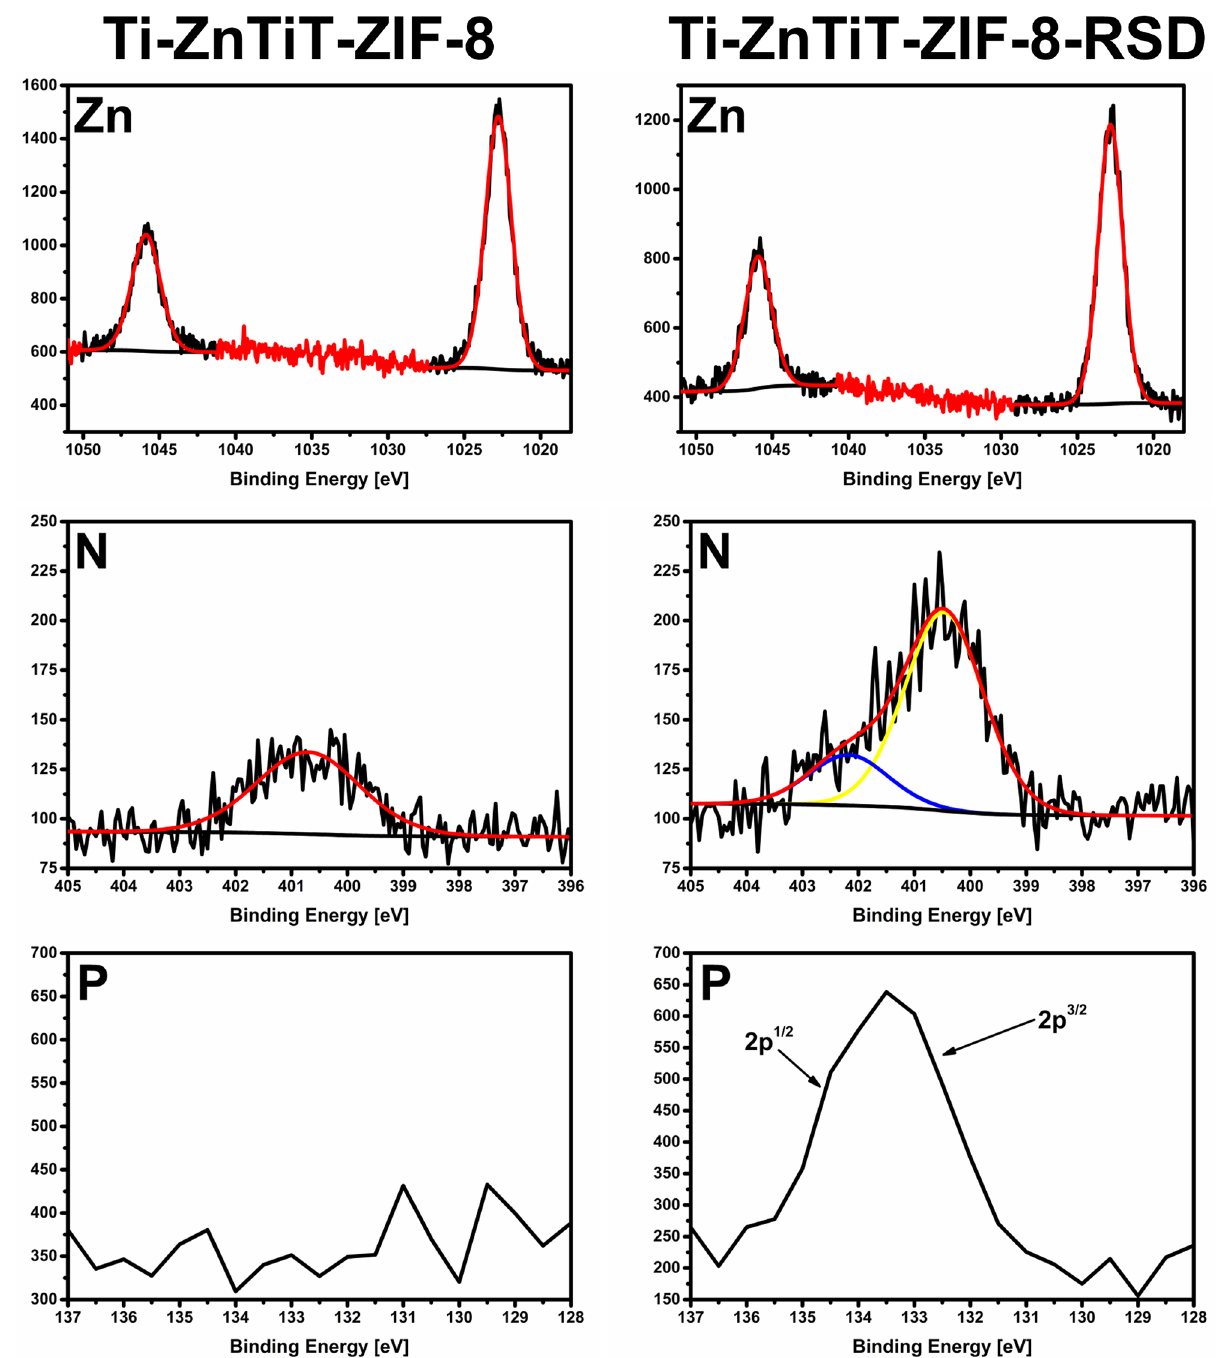
Figure 5. High-resolution XPS spectra of zinc, nitrogen, and phosphorous for the Ti ZnTit-ZIF-8 and Ti-ZnTit- ZIF-8-RSD